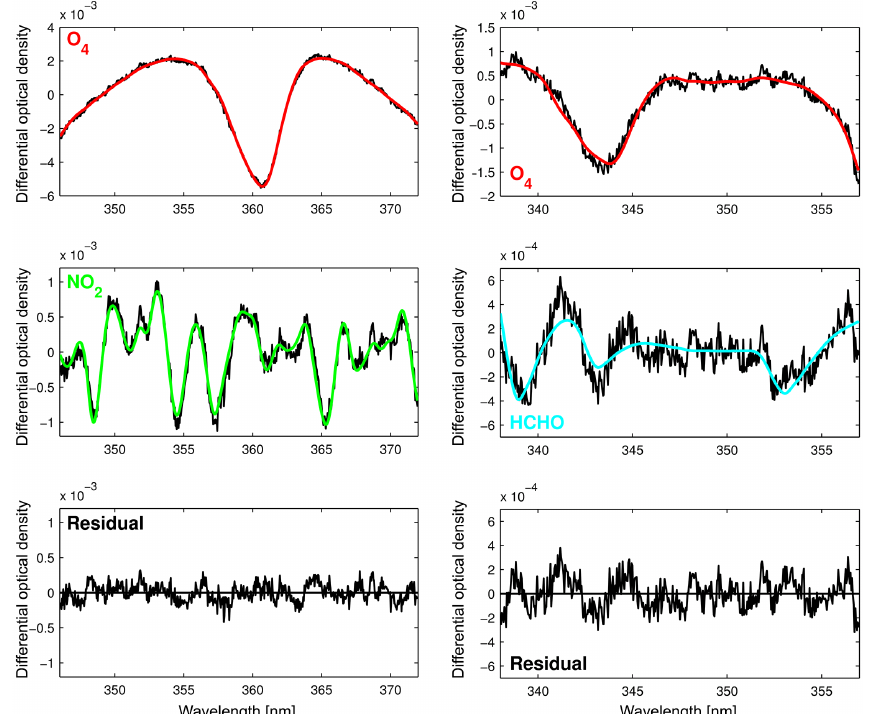
Figure 2. Exemplary fit results of the DOAS analysis in the 346–372nm (left) and 338–357nm (right) fitting window for a horizontal noontime MAX-DOAS spectrum ( α = 0 ◦ , SZA = 37.86 ◦ ) as measured on 16 April 2003 at Zugspitze under elevated NO 2 (DSCD = 1 . 228 × 10 16 moleccm − 2 ) and HCHO (DSCD = 1 . 737 × 10 16 moleccm − 2 ) pollution. The red (upper panel), green (middle panel), and cyan (middle panel) lines show the O 4 , NO 2 , and HCHO cross sections, respectively, as scaled to the O 4 , NO 2 , and HCHO absorptions detected in the measured spectrum (black lines). The residuals with calculated root mean square (rms) errors of 1 . 2 × 10 − 4 (346–372nm) and 1 . 3 × 10 − 4 (338–357nm) are also shown (lower